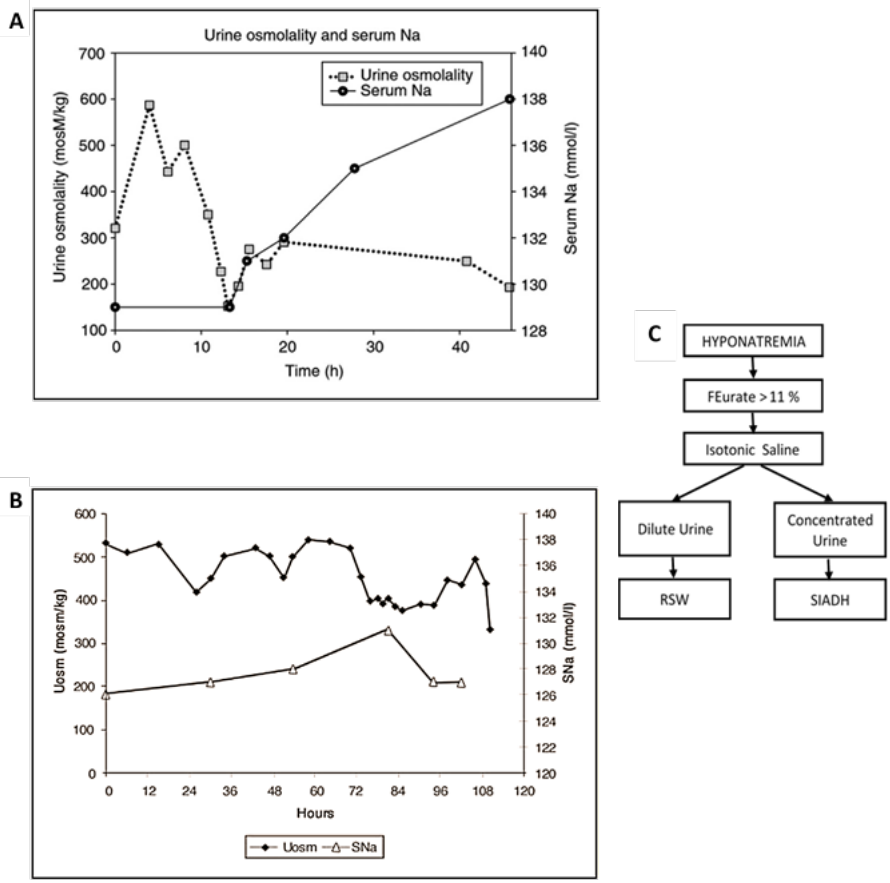
Figure 3. Effect of isotonic saline on urine osmolality. ( A ) The effect of isotonic saline infusion on urine osmolality and serum sodium in a volume depleted hip fracture patient without cerebral disease who had increased plasma levels of renin, aldosterone and ADH. Graph. Note progressive dilution of urine with undetectable level of ADH when urine was most dilute. Because water was removed from the body by excretion of dilute urines, serum sodium normalized within 48 h. ( B ) Graph showing response to isotonic saline infusion in a patient with SIADH who had increased blood volume and decreased plasma renin and aldosterone levels. Note the absence of dilute urines or correction of hyponatremia. This patient failed to inhibit ADH in the absence of volume depletion and presence of hypo-osmolality to meet criteria for SIADH. ( C ) Algorithm using urine osmolality response to isotonic saline to differentiate SIADH from RSW.